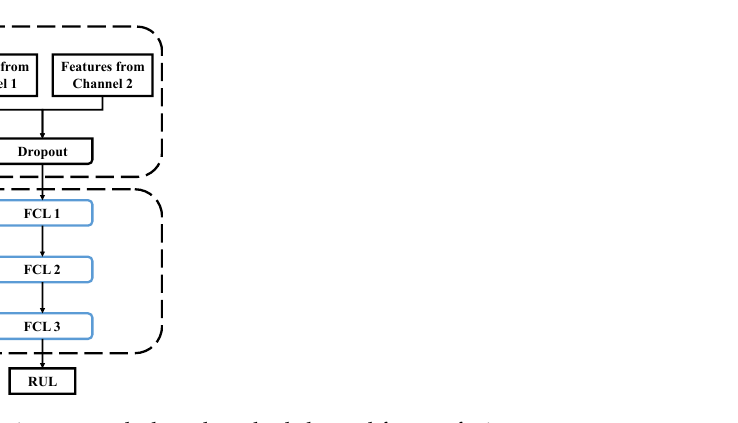
Figure 6. RUL prediction networks based on dual channel feature fusion.